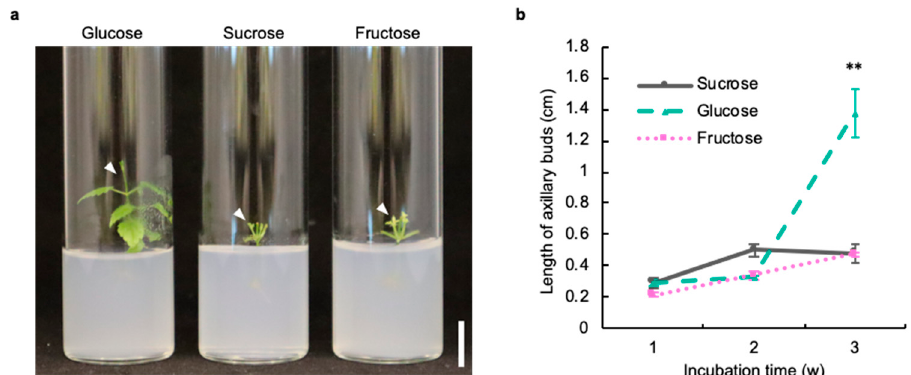
Figure 1. The development of axillary buds of hop requires glucose as a sugar source. ( a ) Axillary bud development in stem explants of hop cultivar Kirin-2 cells were treated with glucose, sucrose, or fructose for 3 weeks. The white arrowheads indicate elongated axillary buds. Scale bar: 1 cm. ( b ) Length of axillary buds in stem explants treated with glucose, sucrose, or fructose each week for 3 weeks ( n ≥ 10 individual experiments, ** p < 0.01; Tukey–Kramer test).